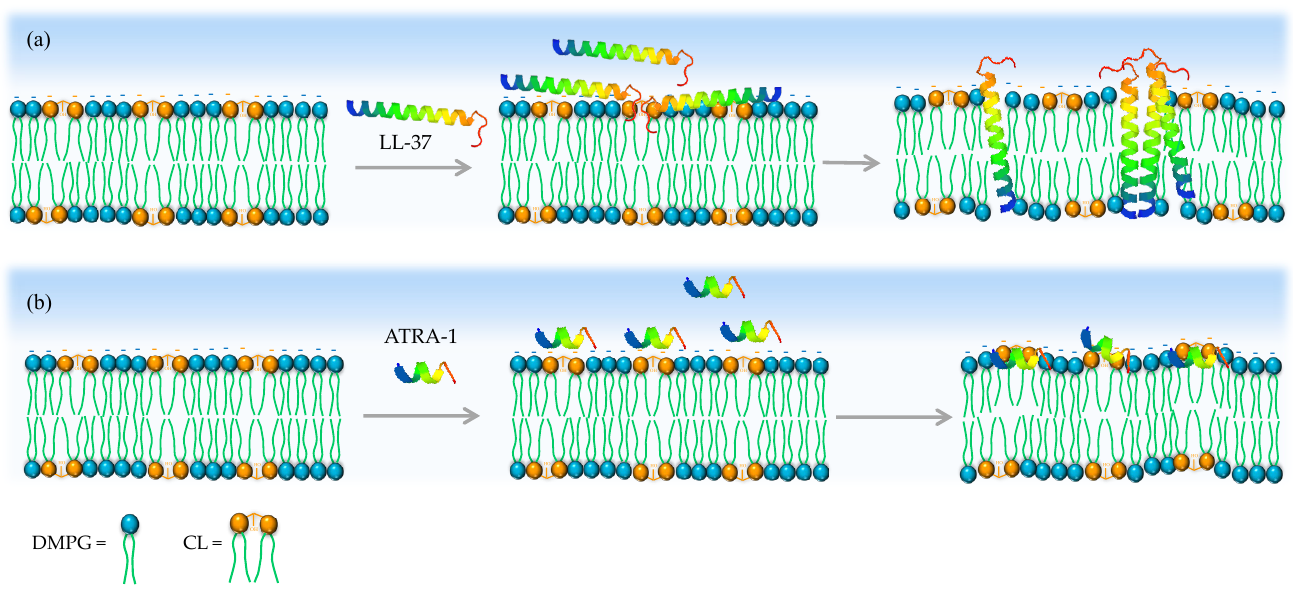
Figure 7. Proposed model for how CL inhibits ATRA-1 pore forming activity. ( a ) LL-37 can insert in the membrane after binding in the presence of CL. ( b ) In contrast, ATRA-1 binds to the membrane surface but does not insert into the membrane core in the presence of CL.